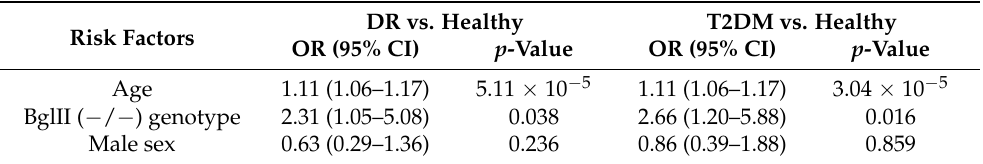
Table 5. Odds ratios (OR) adjusted by logistic regression analysis for the association with type II diabetes